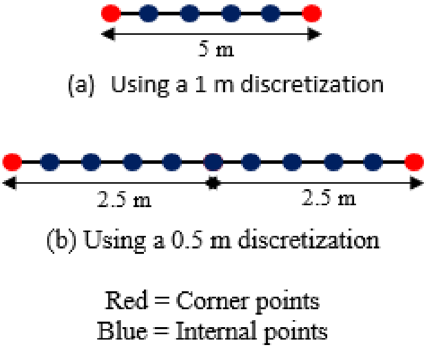
Figure 1. The effect of discretisation size on surface